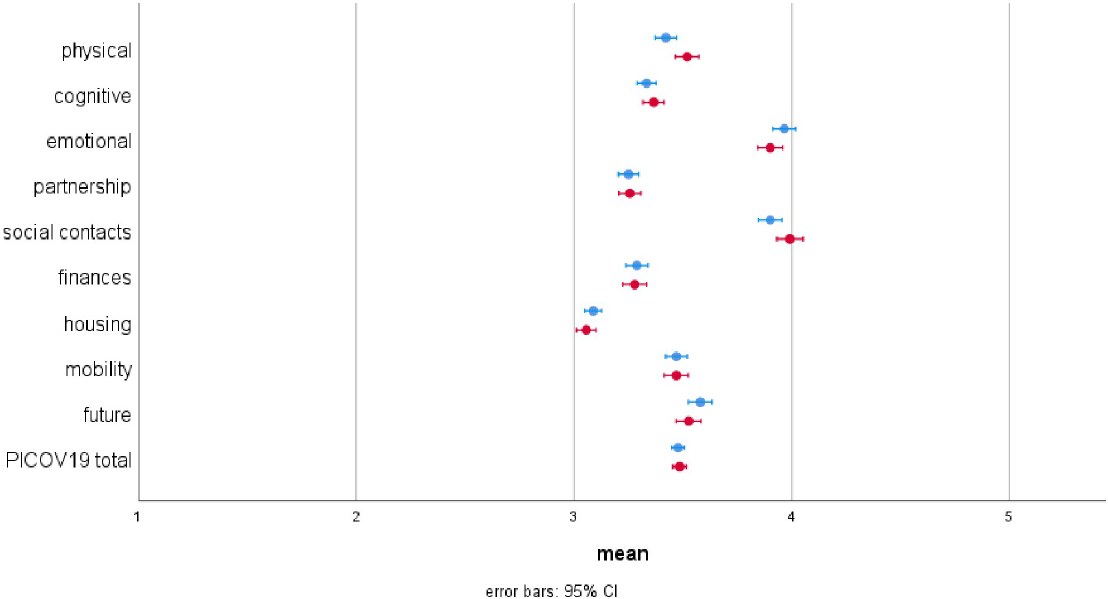
Fig 1. Means and 95% confidence intervals of the PICOV19 items and the total score at baseline (blue) and six months follow-up (red). The scale is reversely coded indicating: 1 = very positive effects; 2 = positive effects; 3 = neither positive nor negative effects, 4 = negative effects, 5 = very negative